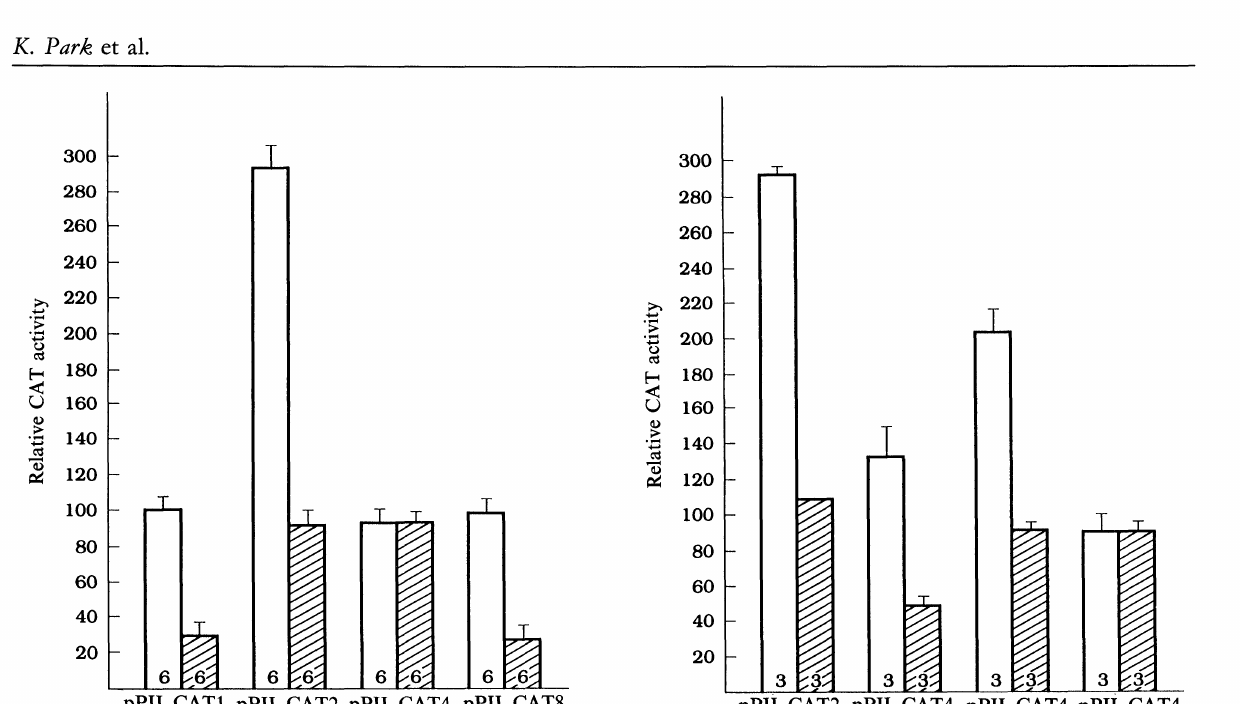
FIG. 7. Effect of the 30-mer cis element (-389/-359) on TNF action. The constructed plasmid (pPII-CAT8, Fig. 1A) containing the fragment (-389/-359) at the position -285 (pPII-CAT4) was transfected into 80-90% confluent 30A5 cells. The cells were harvested for CAT assay after 60 h of incubation in the presence or absence of TNF. The CAT activity obtained from pPII-CAT1 which was included in each experiment was set as 100%. The number of plates used to obtain data for each bar is indicated. Error bars indicate the range of three determinations. Key as Fig. 2.